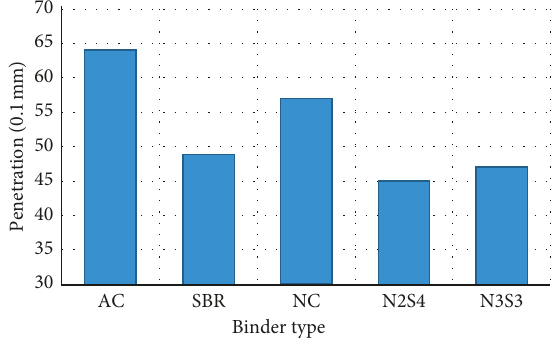
Figure 2: Penetration test.